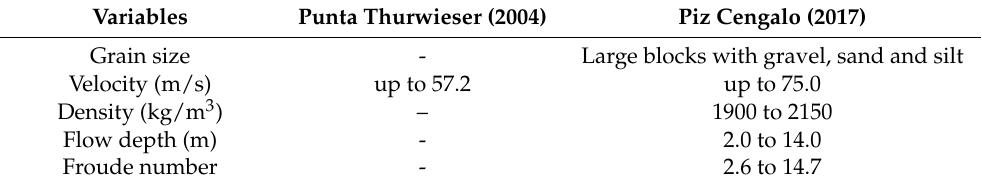
Table 2. Parameters from the back calculation of the Punta Thurwieser and Piz Cengalo events. Variables Punta Thurwieser (2004) Piz Cengalo (2017) Grain size - Large blocks with gravel, sand and silt Velocity (m/s) up to 57.2 up to 75.0 Density (kg/m 3 ) – 1900 to 2150 Flow depth (m) - 2.0 to 14.0 Froude number - 2.6 to 14.7